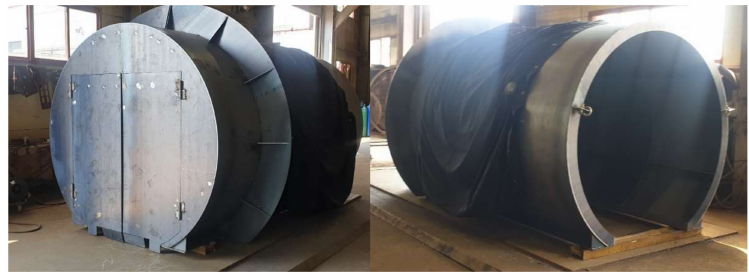
Figure 12. Fabrication of protection